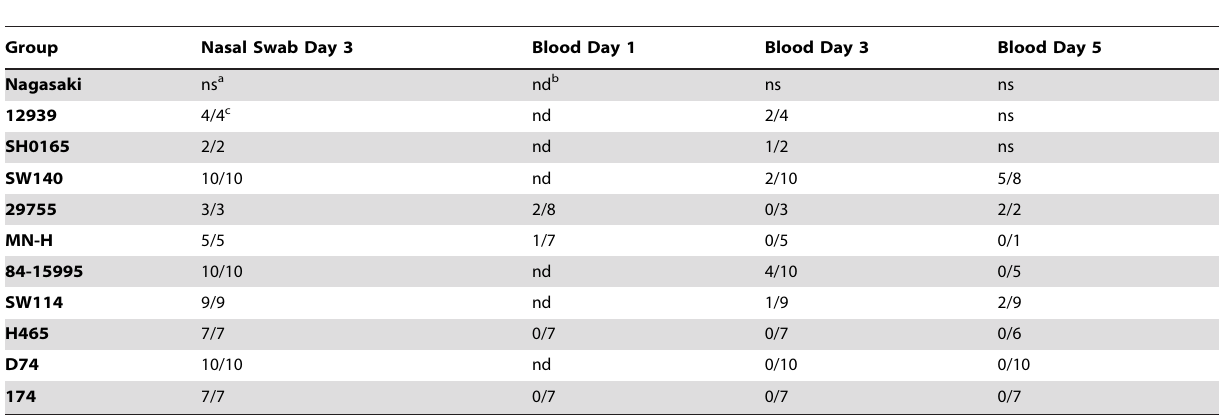
Table 3. Frequency of H. parasuis culture from nasal swab taken on day 3 or blood taken on day 1, 3, or 5 post infection.